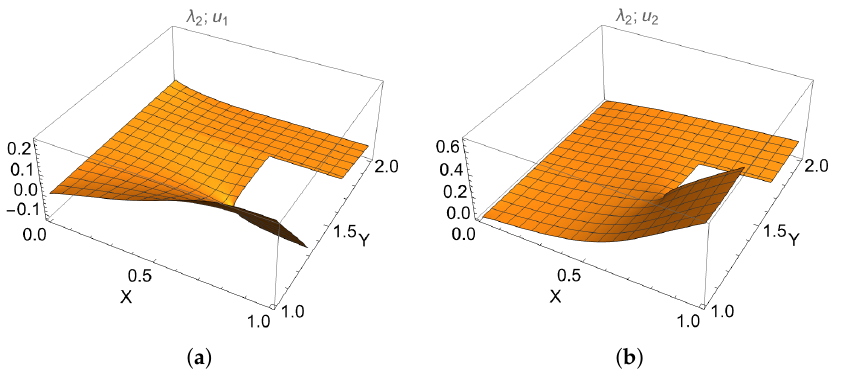
Figure 7. Three regions of uncertain materials. Visualization of the Legendre coefficients of the stochastic modes with the highest pseudoenergies, λ 2 = L 1 selected as the 2nd; ( a ) λ 2 ( u 1 ) and ( b ) λ 2 ( u 2 )